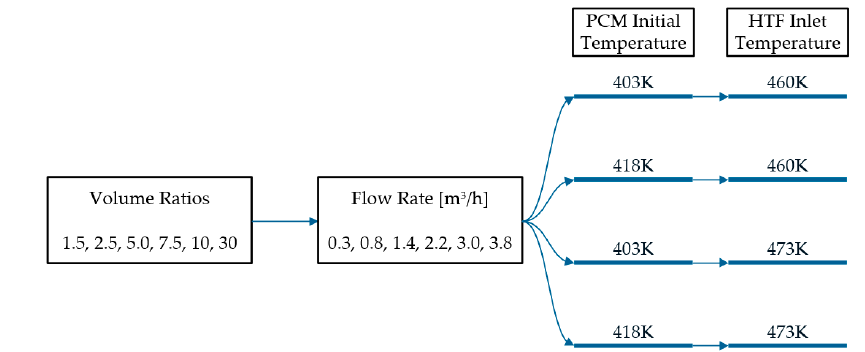
Figure 3. Summary of parametric simulation parameters.